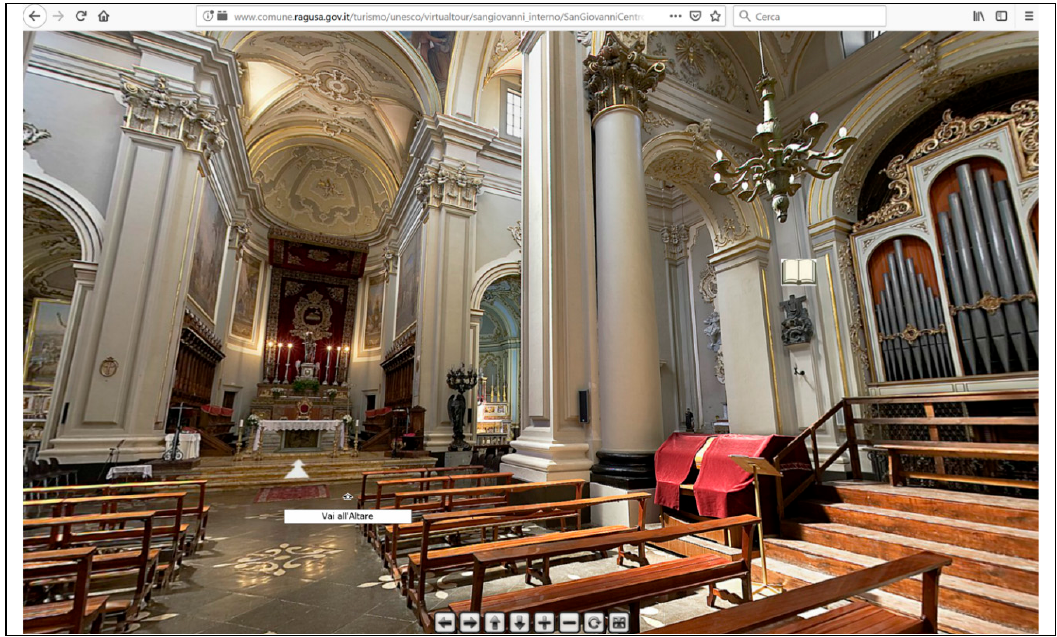
Figure A4. “I Monumenti del tardo barocco di Ragusa: Cattedrale di San Giovanni”. Command bar, link among scenes, hotspots—link for swf file downloading [25].